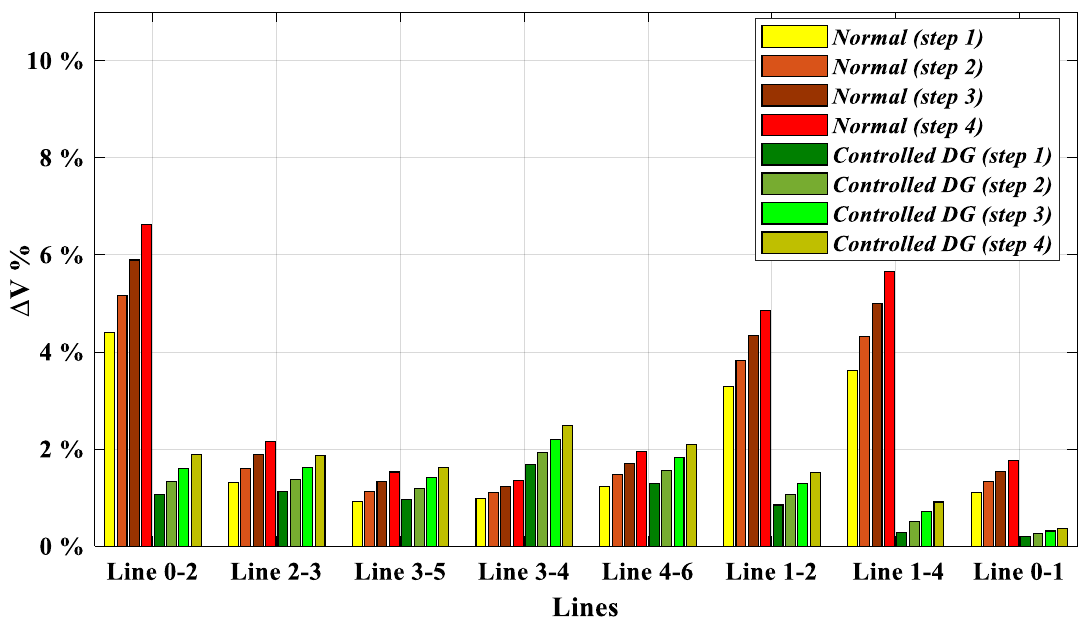
Figure 9. Voltage drop (%) for all transmission lines.